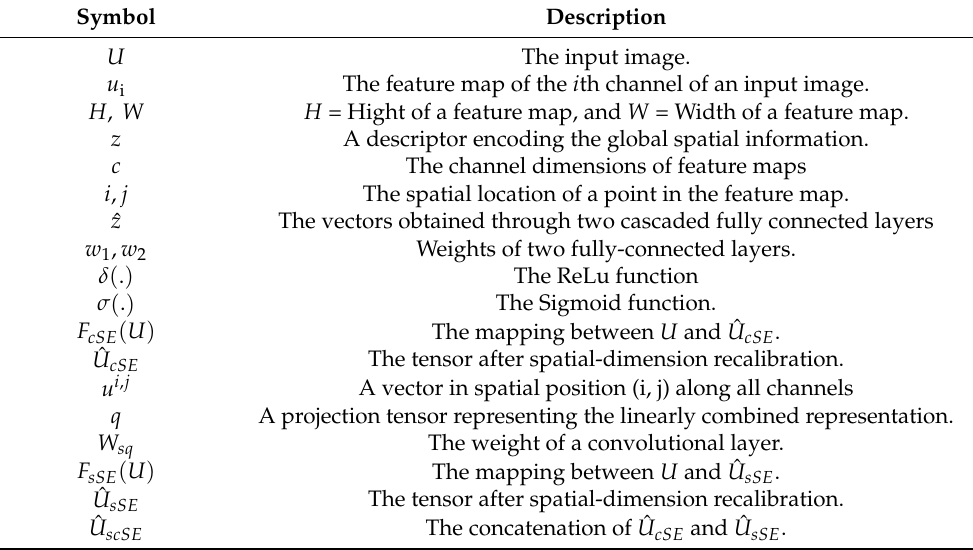
Table 2. Notation and symbols used in this